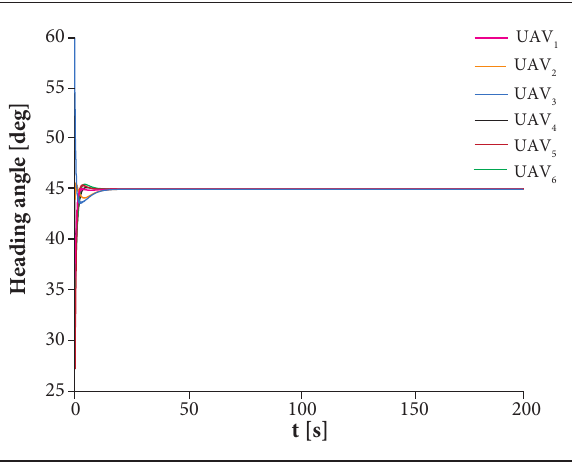
figure 8. Time histories of the velocity.